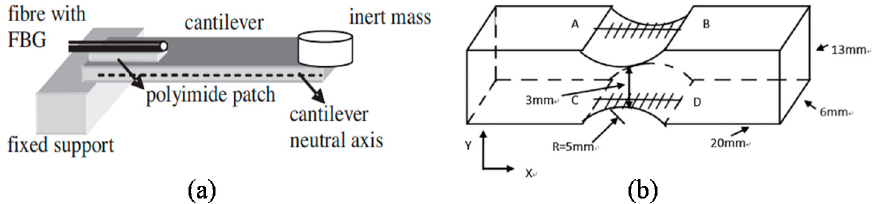
Figure 19. Improved cantilever FBG accelerometer: ( a ) polyimide patch and ( b ) double semicircular flexible hinge. Figures are reprinted with permission from: ( a ) Ref. [84]. Copyright 2012 Elsevier; ( b ) Ref. [88]. Copyright 2014 Elsevier.